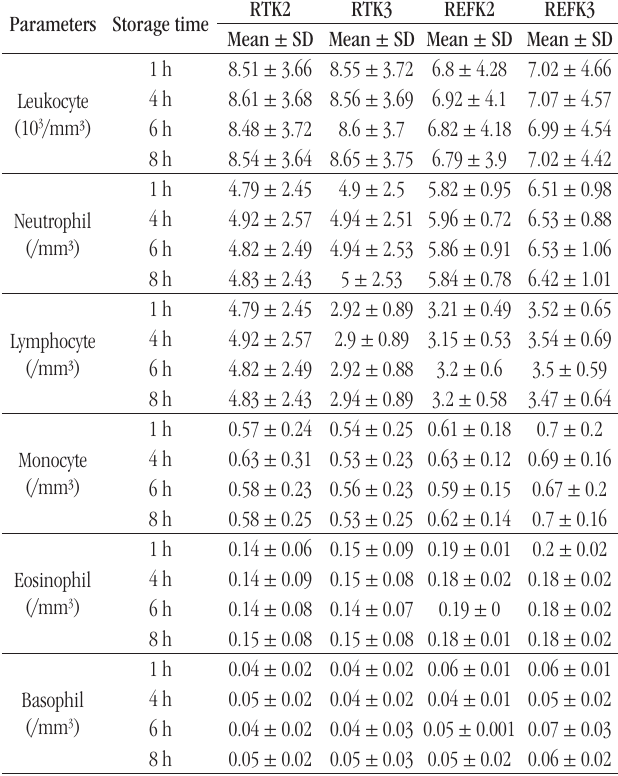
table 1 – Mean profile of erythrocyte parameters, according to temperature and storage time: erythrocyte count, hemoglobin and hematocrit Parameters Storage time